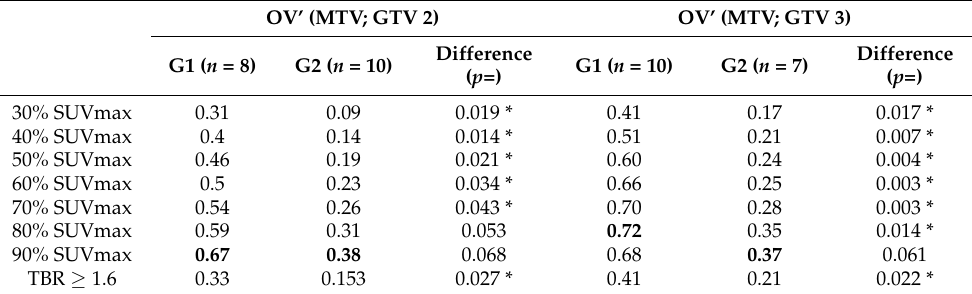
Table 5. Mean ratios of the intersection of MRIs and FET volumes to the FET volume